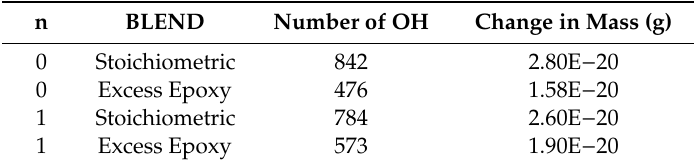
Table 2. Predicted mass lost due to complete dehydration of etherified systems.